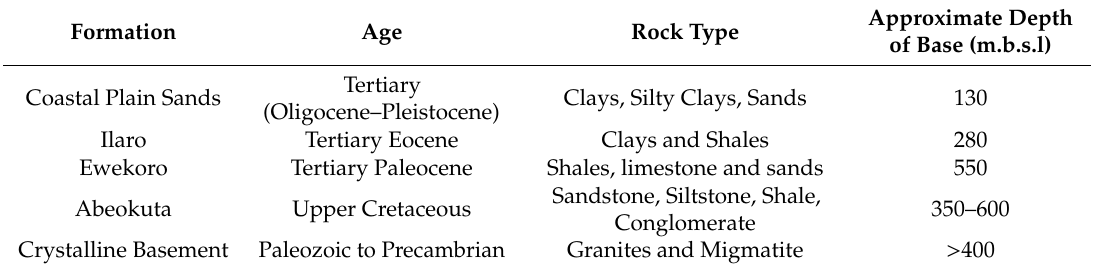
Table 2. Regional electrical conductivity.